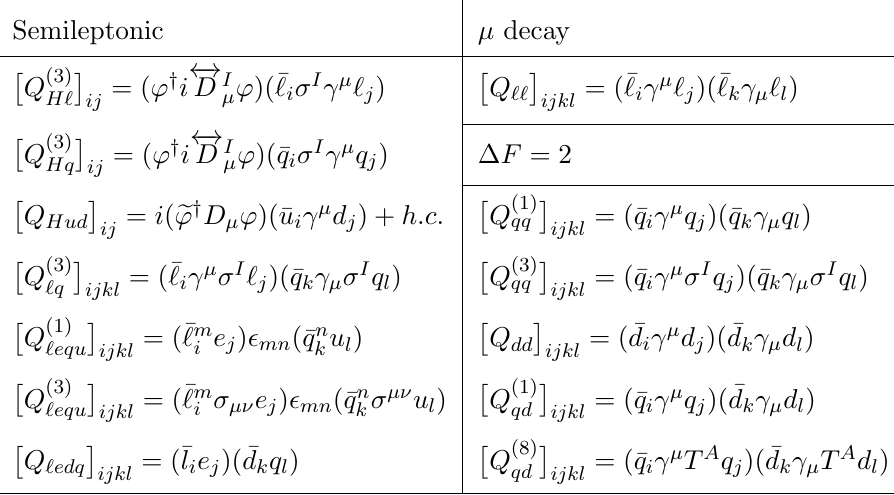
Table 4 . Operators in the SMEFT relevant for (cid:22) decay, semileptonic and (cid:1) F = 2